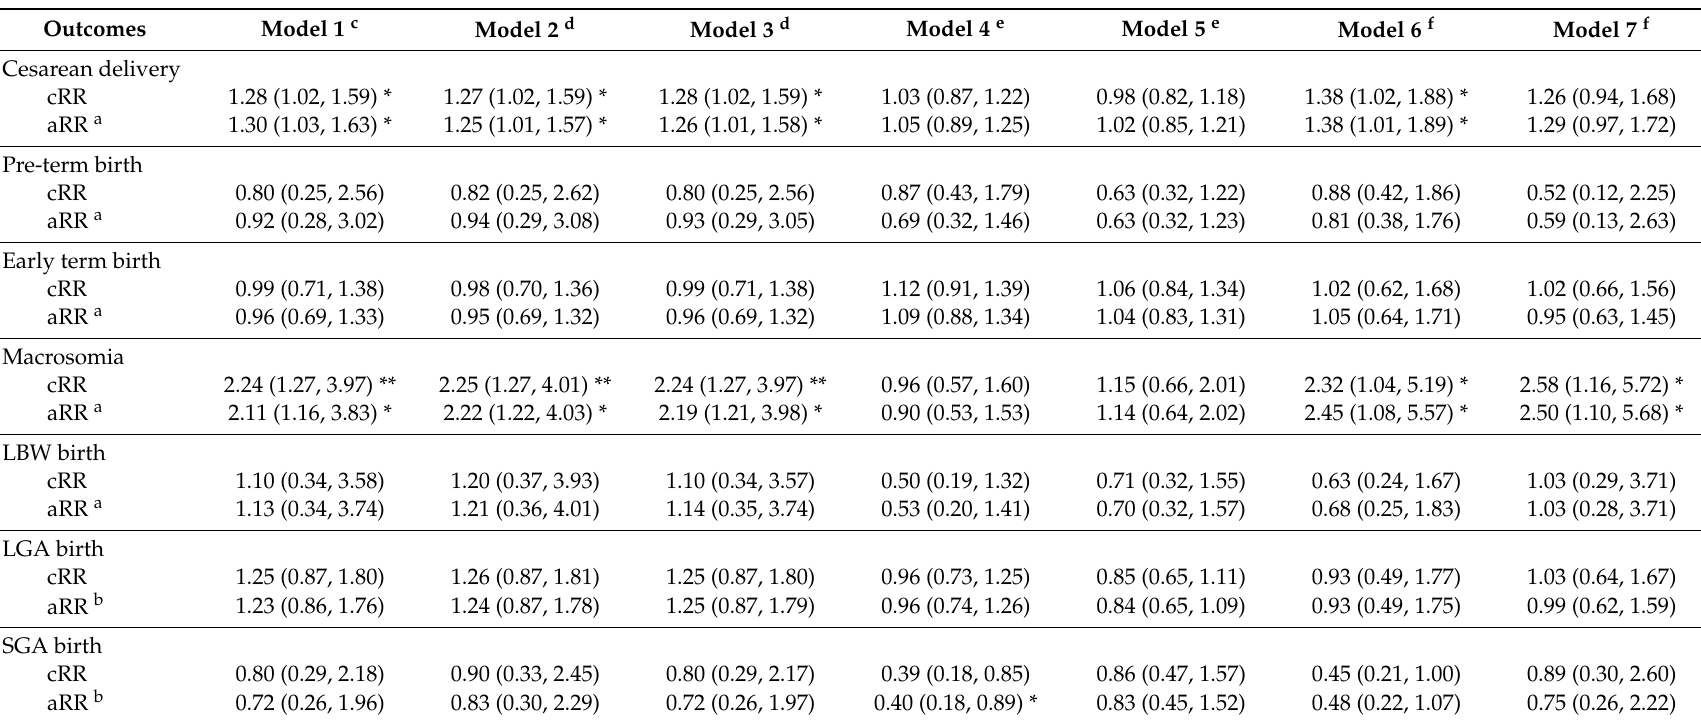
Table 4. E ff ects of GDM and duration of folic acid (FA) supplementation on adverse birth